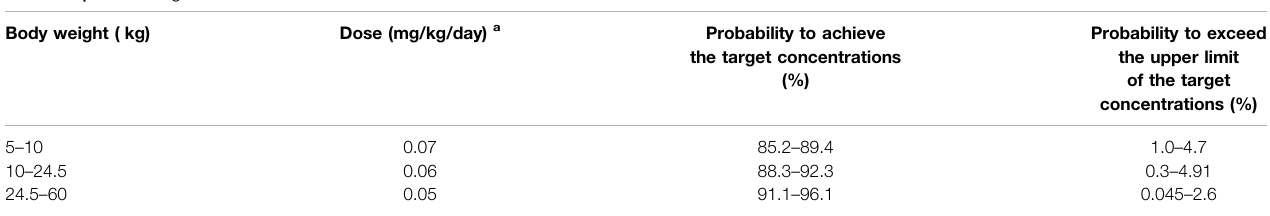
TABLE 3 | Initial dosage recommendation of sirolimus.